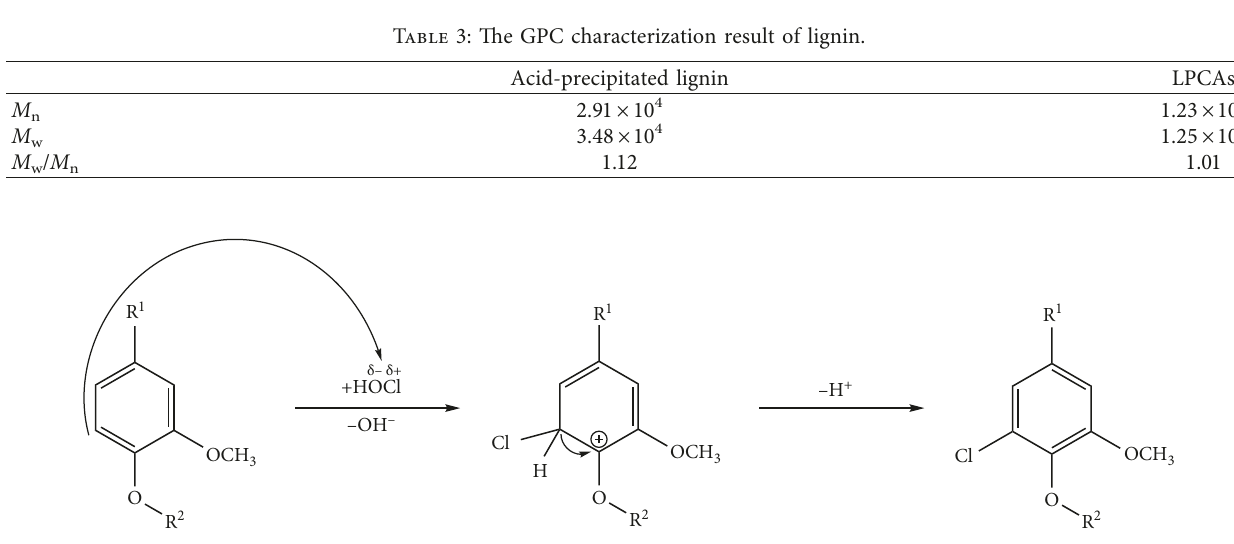
Figure 7: A possible mechanism of the oxidation of lignin by NaOCl.